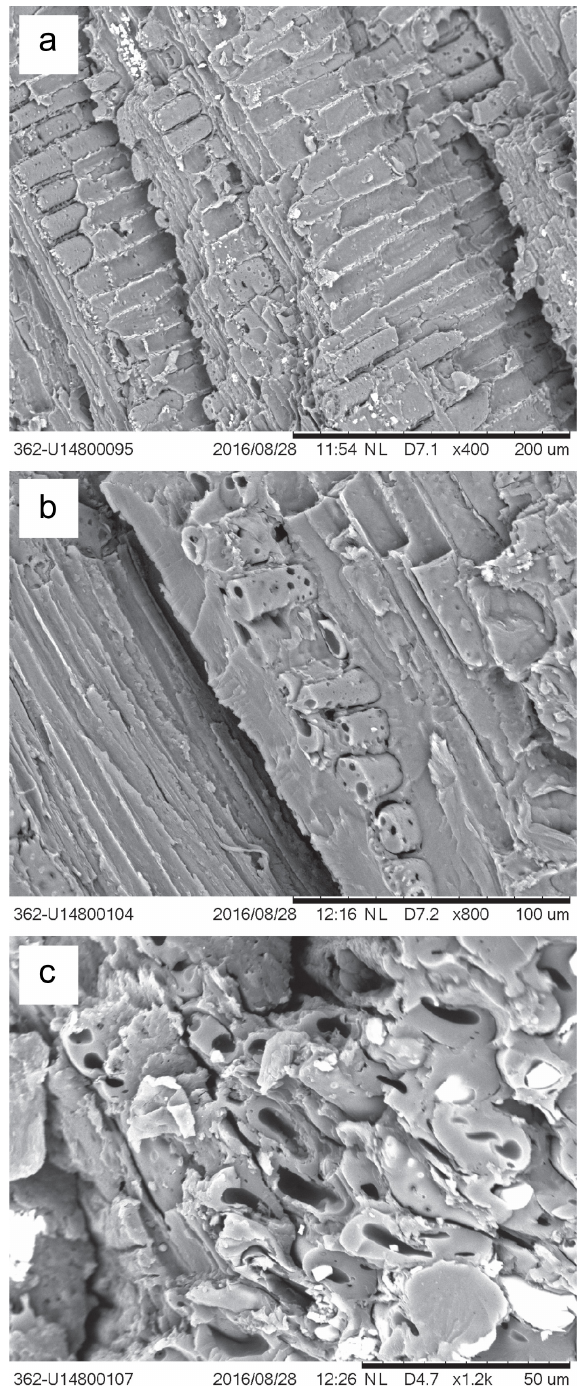
Figure 3. Shipboard SEM images of angiosperm wood fragments from IODP Site U1480 cores. (a) Radial view of ray cells showing rays cells (horizontal orientation in the original tree) with tiny pits on ray cell walls, and several ray cell lumen with infills. (b) Oblique view showing the tangential cross section of a ray composed of nu- merous cells (some with infilling). Vertical fibers are visible on the left. (c) Oblique transverse view showing the transverse section of fiber walls, which have been slightly